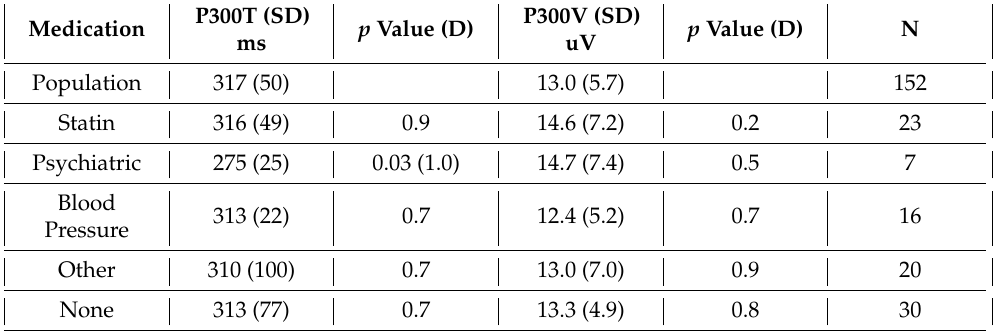
Table 3. Differences in P300 between subjects for each medication group as compared to the entire study sample. “Other” refers to those not on statins, psychiatric medications, or blood pressure medication. A 2-tailed t -test was utilized. Bold values represent significant differences, p < 0.05, and large effect sizes (D) Cohen’s D > 0.55. No effect sizes are given for non-significant parameters. P300T (SD) P300V p Value (D) Medication ms